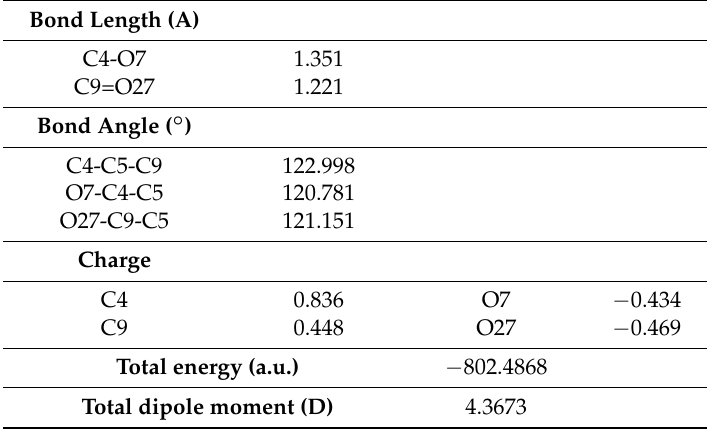
Figure 5. The optimised structure of the electronic ground state of complexes ( 1 )–( 4 ) at the uB3LYP level of theory (6-31G(d) basis set for C, H atoms; 6-31G+(d,p) for O atoms; MWB28 for lanthanide atoms). Table 2. Geometric parameters bond lengths (A), bond angles (°), charge density, total energy (a.u.) and total dipole moment (D) of 5-hydroxyflavone as resulted from DFT calculations.